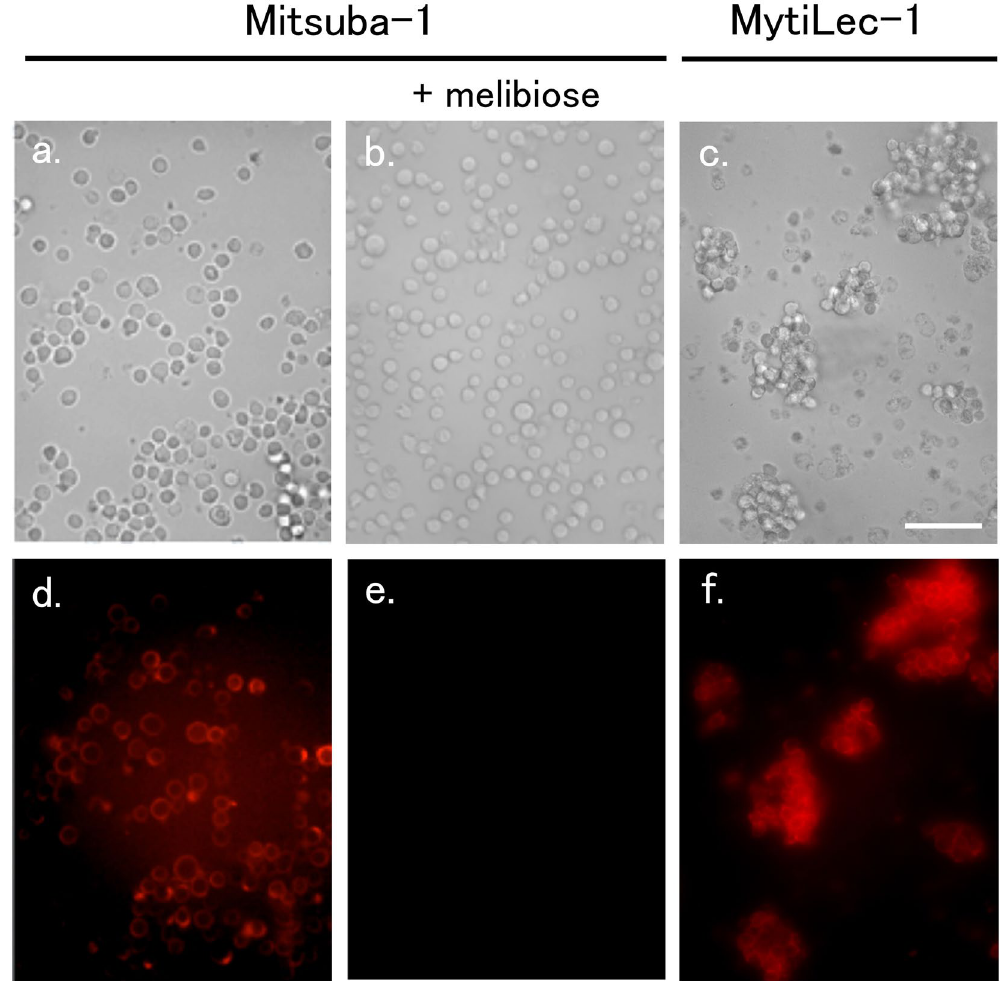
Figure 7. Agglutination of Raji cells. Mitsuba-1 (100 μ g/mL) showed no effect on cell structure in the absence ( a ) or presence ( b ) of melibiose. MytiLec-1 at the same concentration produced cell clumping ( c ). Labelled Mitsuba-1 binds to Raji cells in the absence ( d ) but not presence ( e ) of melibiose. Labelled MytiLec-1 is also found bound to the cell membranes ( f ).